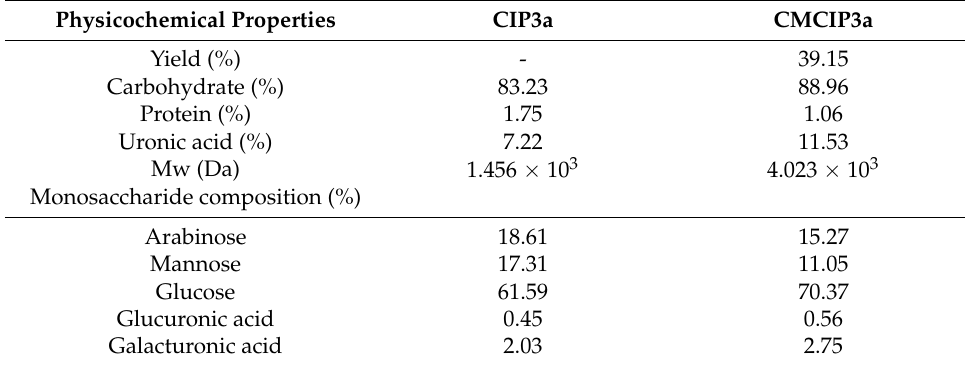
Figure 2. Mechanism of carboxymethylation reaction. Table 1. Chemical composition of CIP and its derivative #